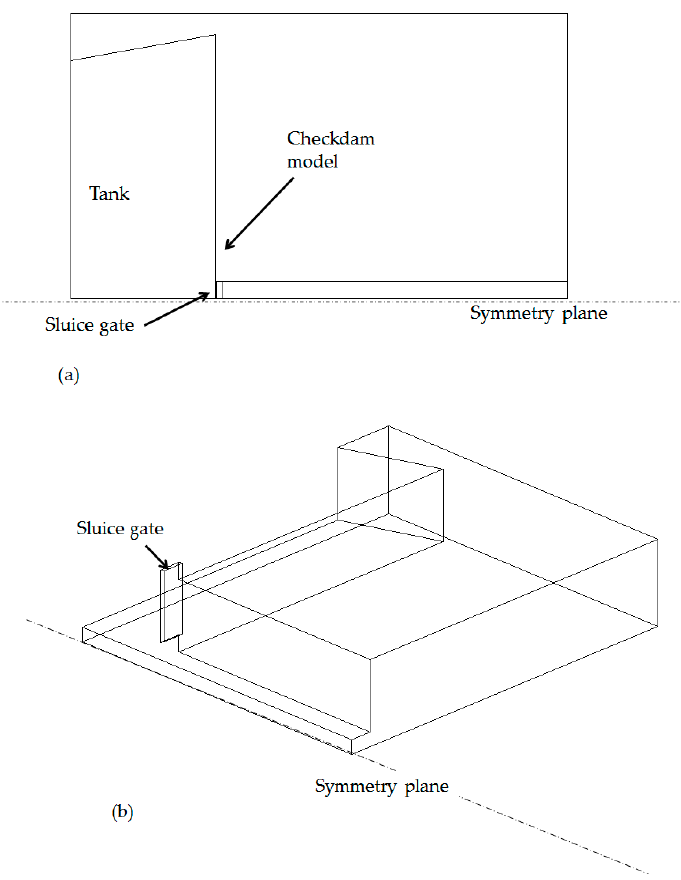
Figure 3. Computational domain: ( a ) plan view and ( b ) 3D view from downstream.